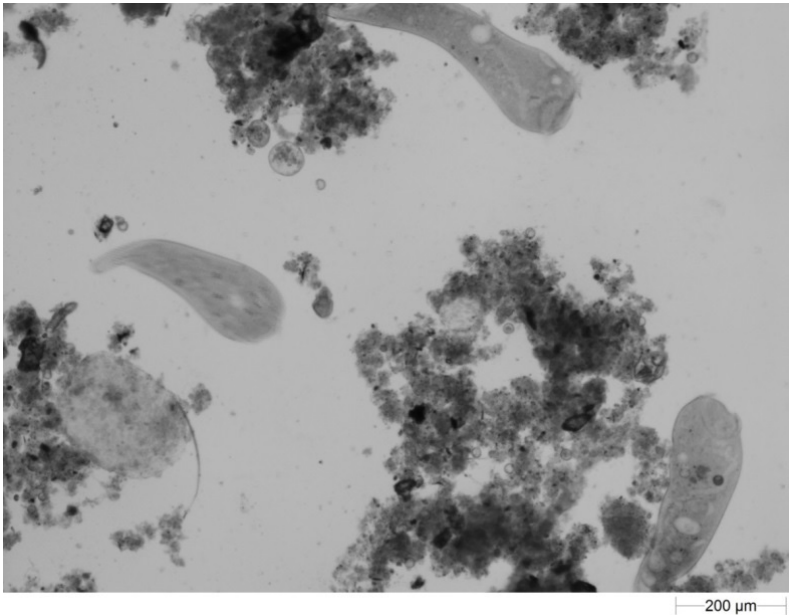
Figure 11. Stentor sp. in activated sludge—59th day of operation.